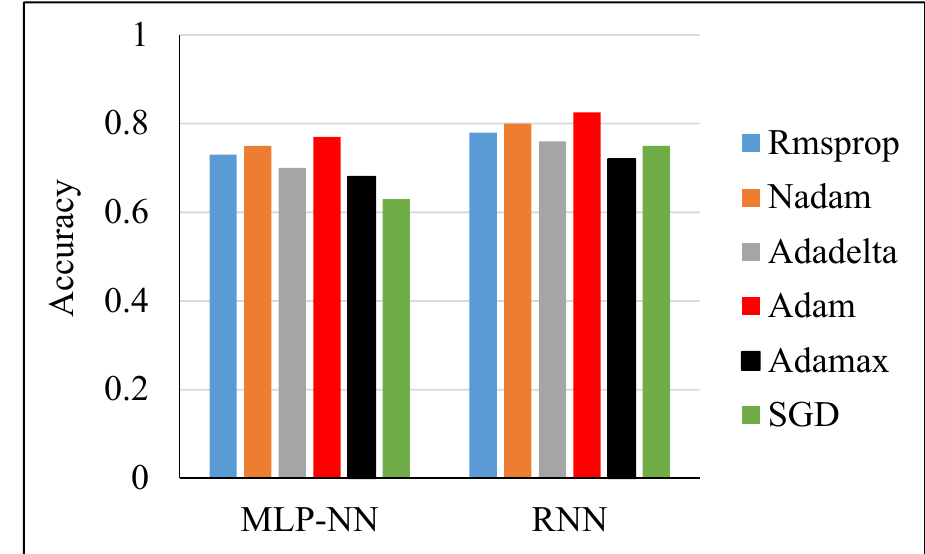
Figure 11. Impact of the optimization algorithm on the performance of MLP ‐ NN and RNN models; SGD: Stochastic Gradient Descent.